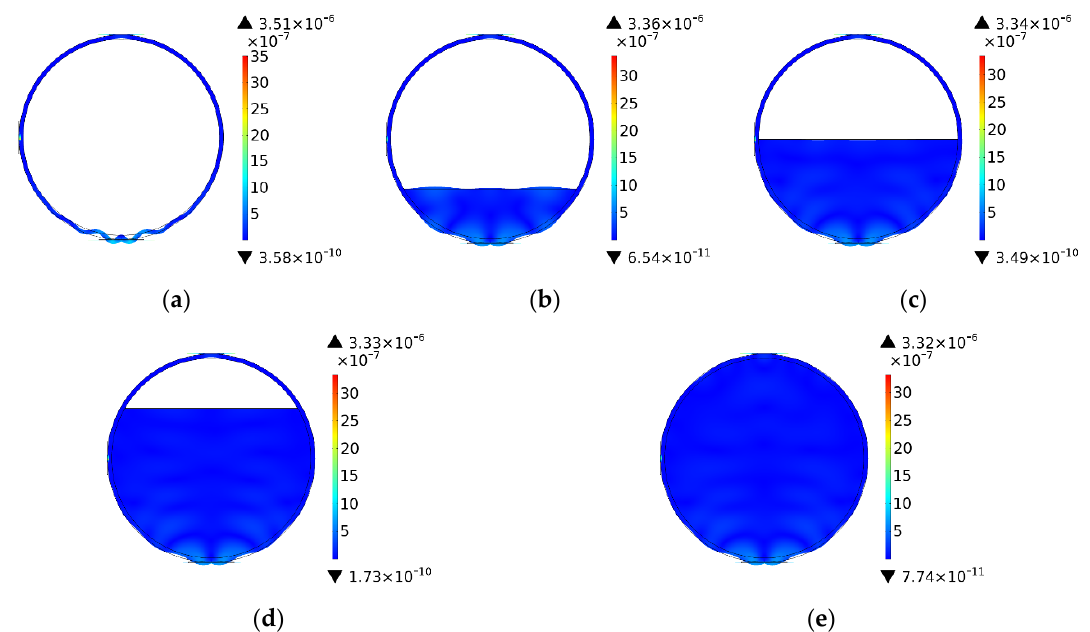
Figure 13. The structural deformation excited by PZT patches at frequency P1 (unit: mm). ( a ) Empty; ( b ) 25%; ( c ) 50%; ( d ) 75%; ( e )